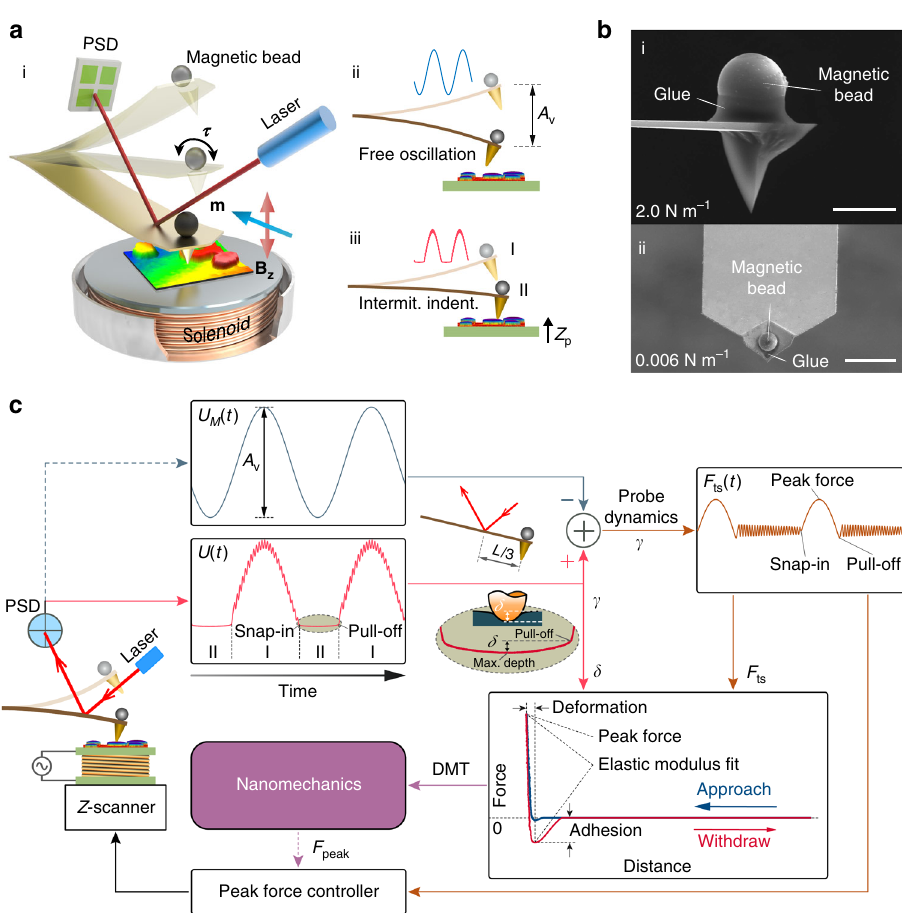
Fig. 1 Scheme of magnetic drive peak force modulation AFM. a (i) Design of the experimental setup in which a magnetic bead probe is oscillated at an off- resonance frequency by a magnetic torque τ in an AC magnetic fi eld ( B z ) generated by the solenoid underneath. (ii) The probe oscillates near the sample surface with a free amplitude of A v and (iii) intermittently indents the sample through the translation of the Z piezo-scanner. b SEM images of the probes with spring constants of 2 N m − 1 (i) and 0.006 N m − 1 (ii) attached with Ø11.4 μ m and Ø3.8 μ m magnetic beads, respectively. Scale bar, 10 μ m. c Block diagram depicting the data processing fl ow and feedback control of the peak force. The tip-sample interactive response ( F ts ) (dark orange) and the indentation depth ( δ ) can be directly obtained from probe responses U ( t ) with (pink) and U M ( t ) without (dark blue) contact on the sample when the laser spot is located at two-thirds of the length ( L ) of the probe. The nanomechanical properties can then be quanti fi ed using the acquired force-distance